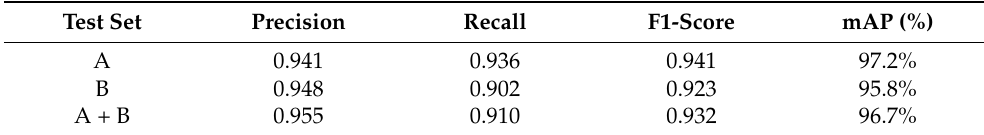
Table 5. Evaluation indicators of wheat ear detection.